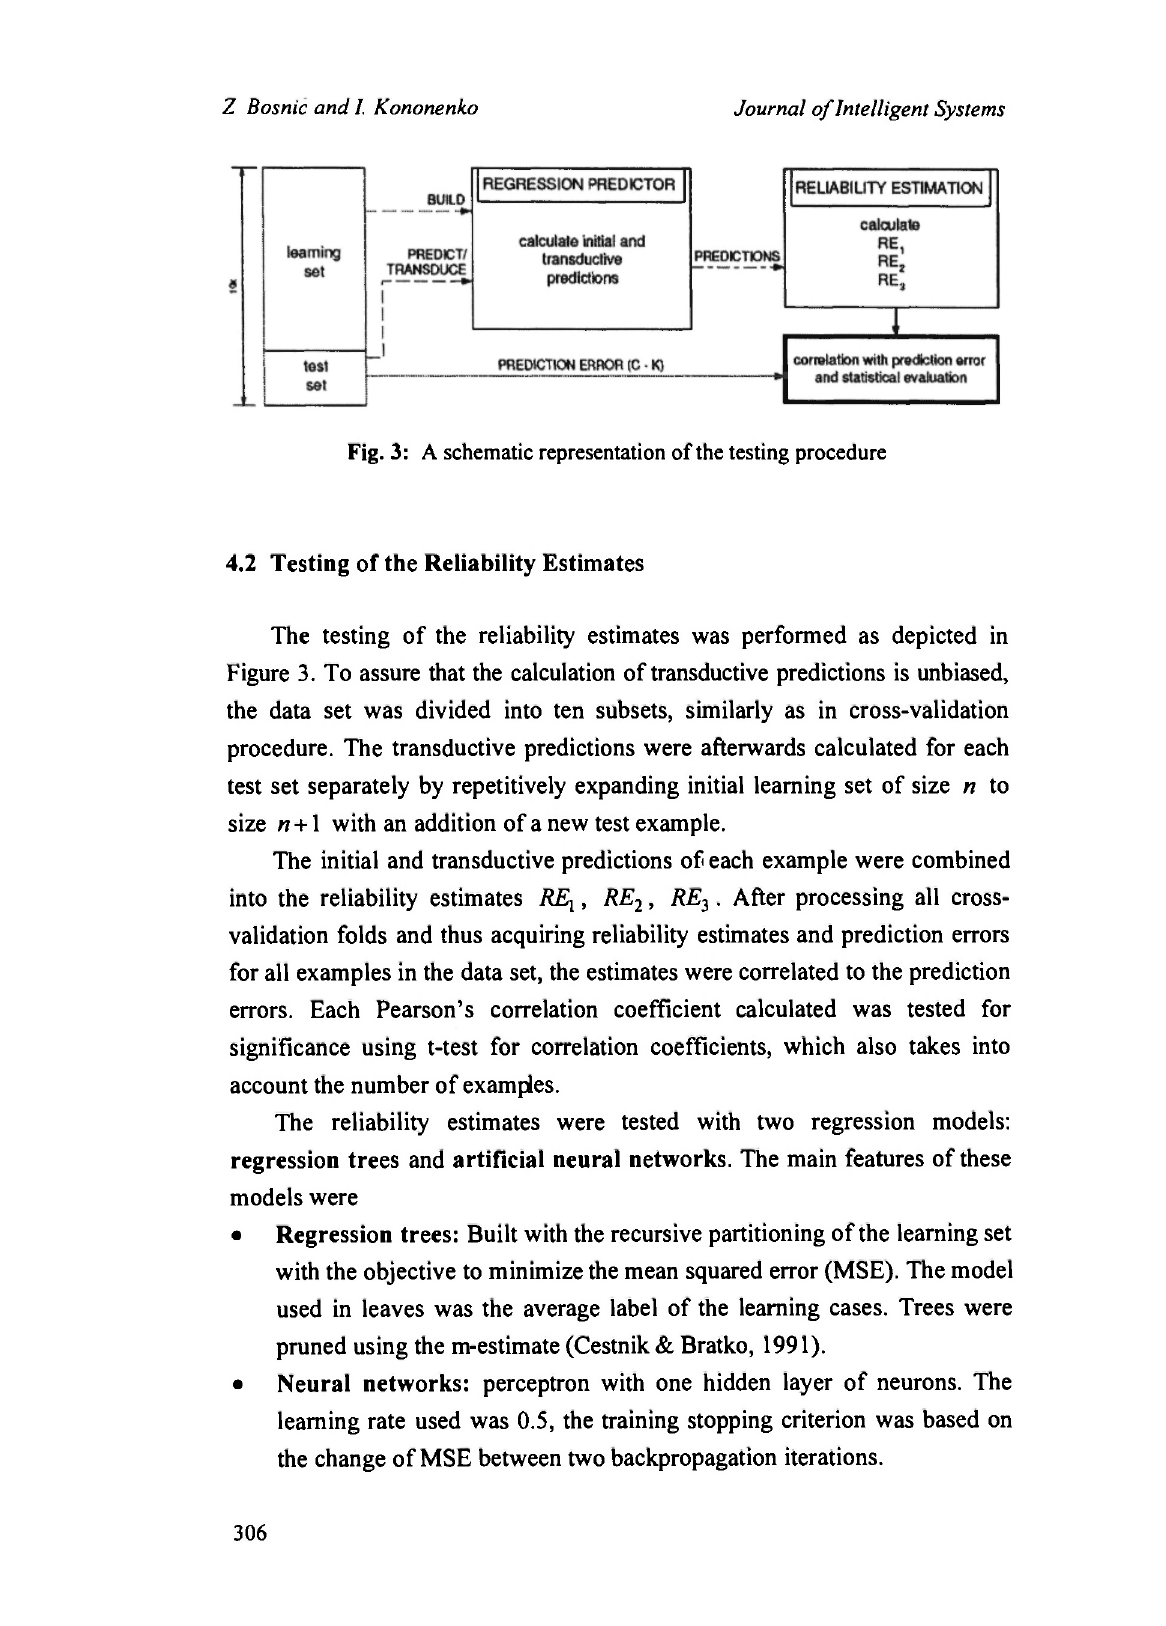
Fig. 3: A schematic representation of the testing